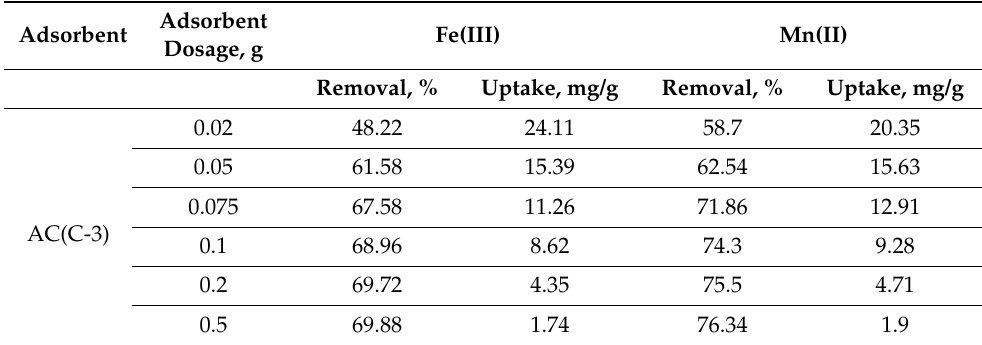
Table 7. The influence of adsorbent dosage on the absorption and removal by AC(C-3) of Fe(III) and Mn(II) from aqueous solutions (conc. = 50 mg/L, time = 60 min, wt. = 0.05 g, agitation velocity = 100 rpm and temp. 25 ◦ C) by